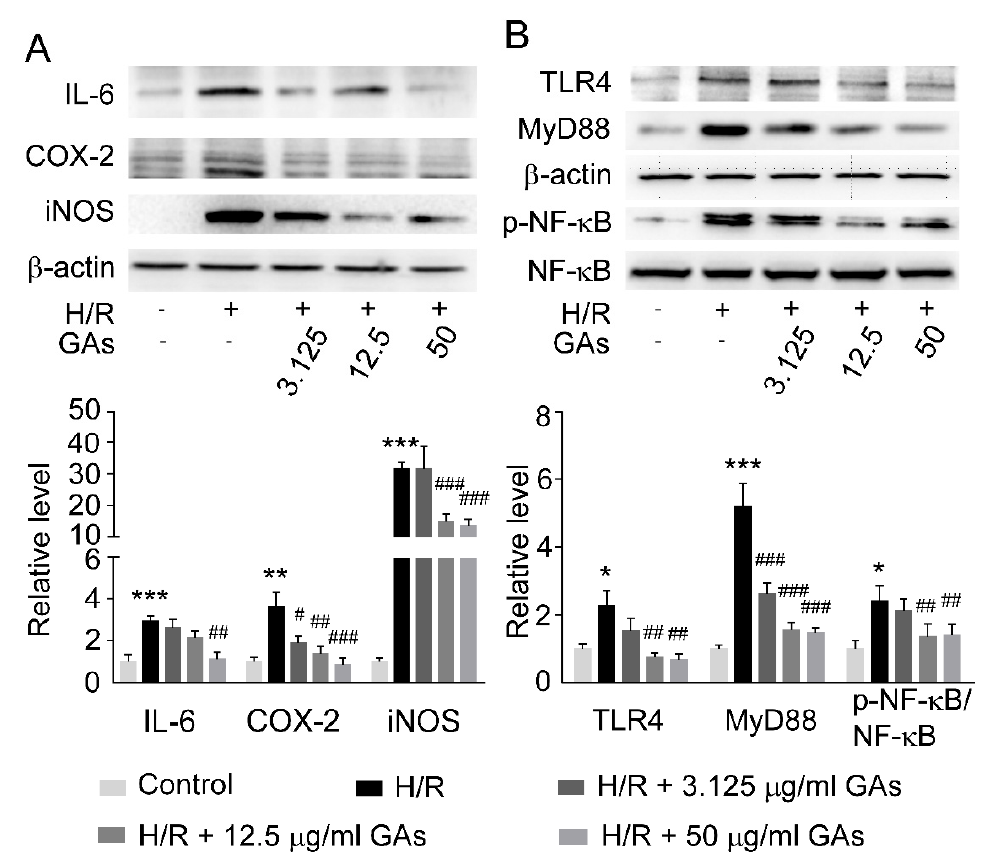
Figure 5. GAs inhibited H/R-mediated inflammation by adjusting TLR4/MyD88/NF-kB signaling in NRK-52E cell. ( A ) Representative Western blots and quantitative densitometric analysis of inflammation-related proteins in NRK-52E cell. ( B ) Representative Western blots and quantitative densitometric analysis of TLR4, MyD88, NF-kB and p-NF-kB in NRK-52E cell. The data of target proteins were normalized to b-actin as internal reference and are expressed relative to the intensity of the Control group. Values are expressed as the mean ± SEM ( n = 5–6). * p < 0.05, ** p < 0.01 and *** p < 0.001 compared with Control group; # p < 0.05, ## p < 0.01 and ### p < 0.001 compared with H/R group (two-tailed Student’s t -test or one-way